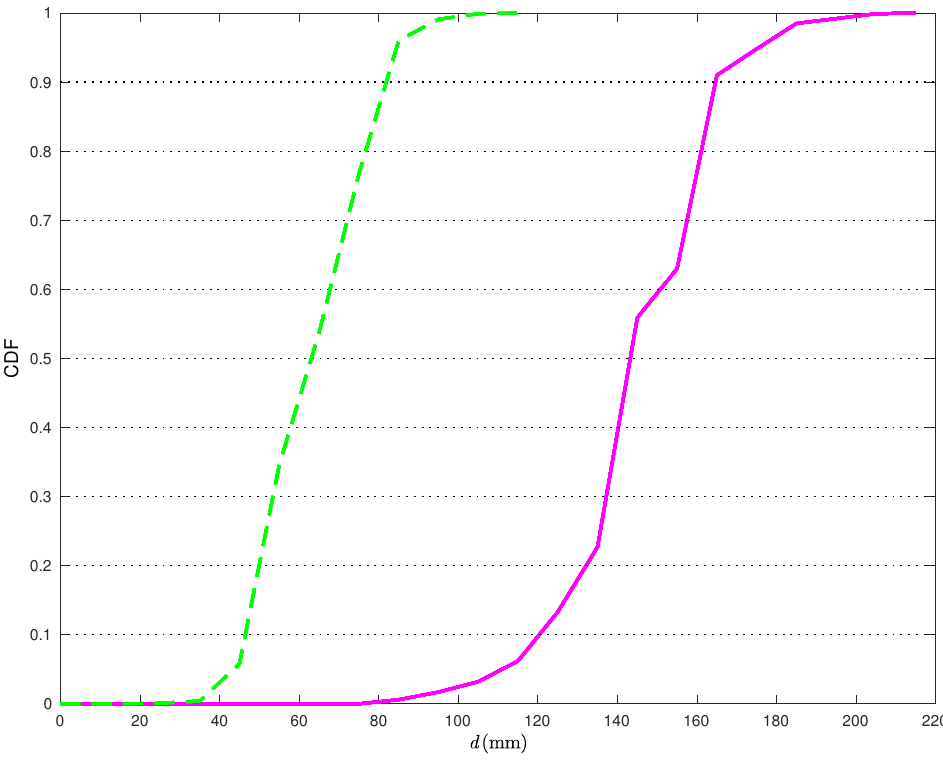
Figure 13. CDFs of the distance errors obtained with the TSML localization algorithm in Figure 12 without (solid line) and with (dashed line) the statistical